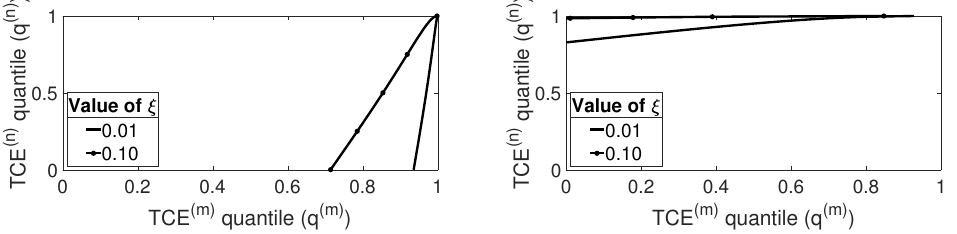
Figure 10. Extended TCE quantile at order n = 2 as a function of extended TCE quantile at order m = 5 with µ = 0. ( Left panel ): σ = 0.1. ( Right panel ): σ = 0.4.